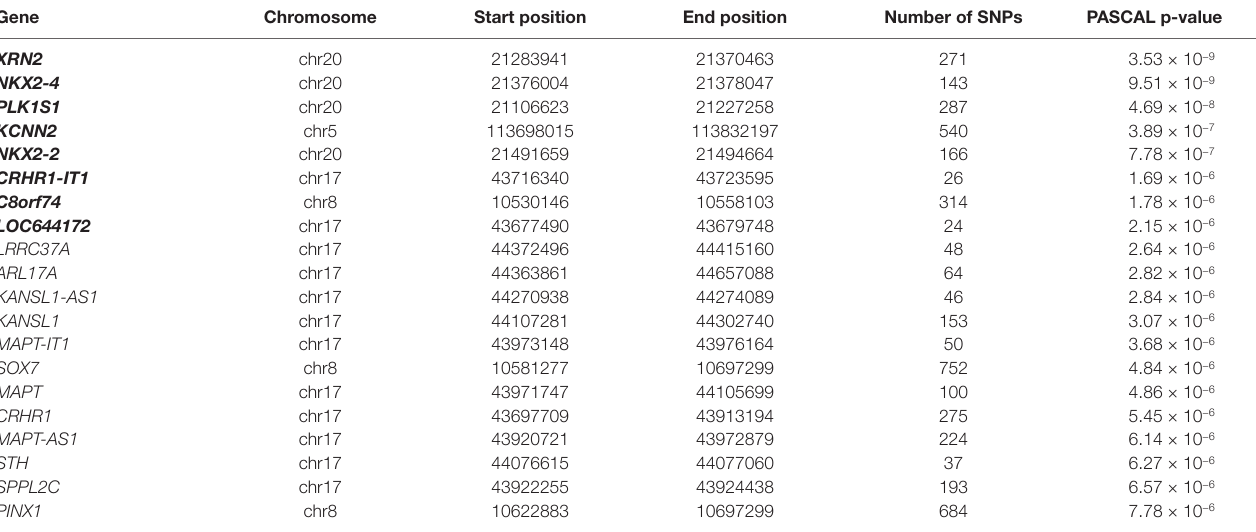
TABLE 3 | Top 20 results reported by PASCAL for ASD GWAS meta-analysis data. Genes represented in bold surpass Bonferroni threshold (p-value < 2.26 × 10 −6 ). Columns show gene, chromosome, start and end positions for each gene, the number of SNPs included in the analysis for each gene, and their PASCAL p-values. Gene